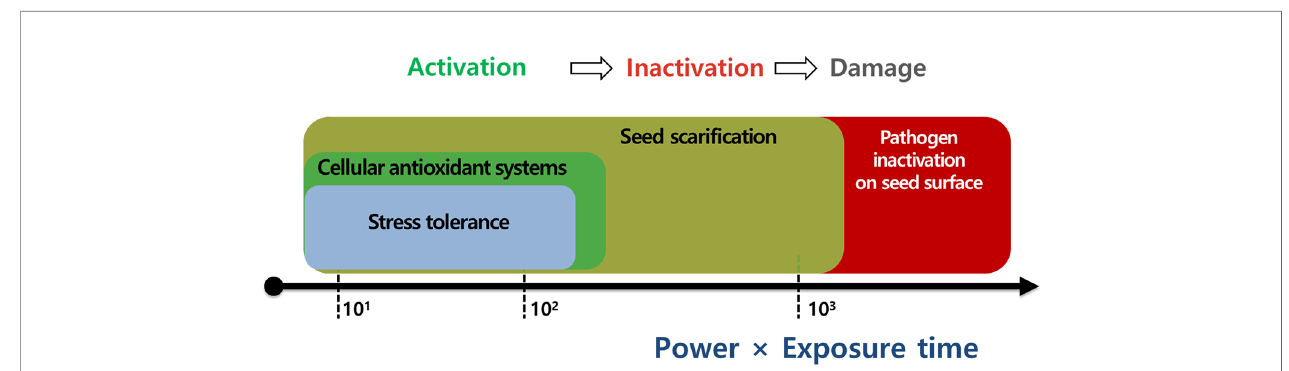
FIGURE 8 | The most important parameters for plasma applications to enhance seed scari fi cation, pathogen inactivation, cellular antioxidant systems, and stress tolerance in seeds or